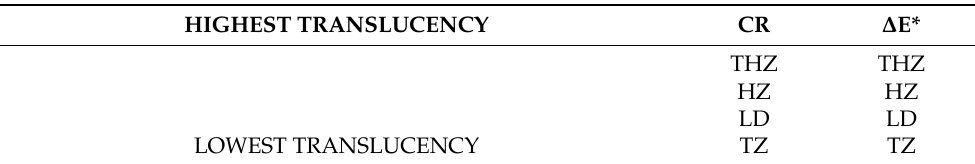
Table 3. Translucency rankings of all materials under study according to the results obtained in Table